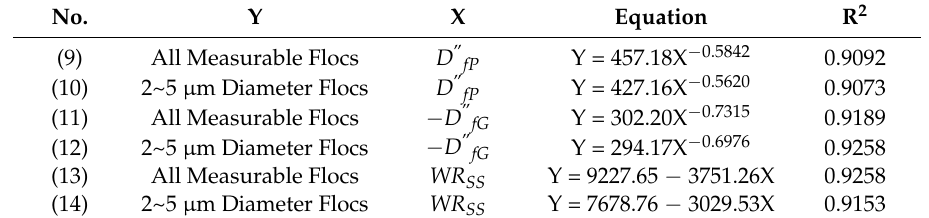
Figure 9. Fitting curves for the particle number in settled water as a function of D ” fP , − D ” fG , and WR ss . ( a ) In the primary stage; ( b ) in the growth stage; and ( c ) in the stable stage. Table 3. Fitting equations for the particle number in settled water as a function of D ” fP , − D ” fG , and WR ss .